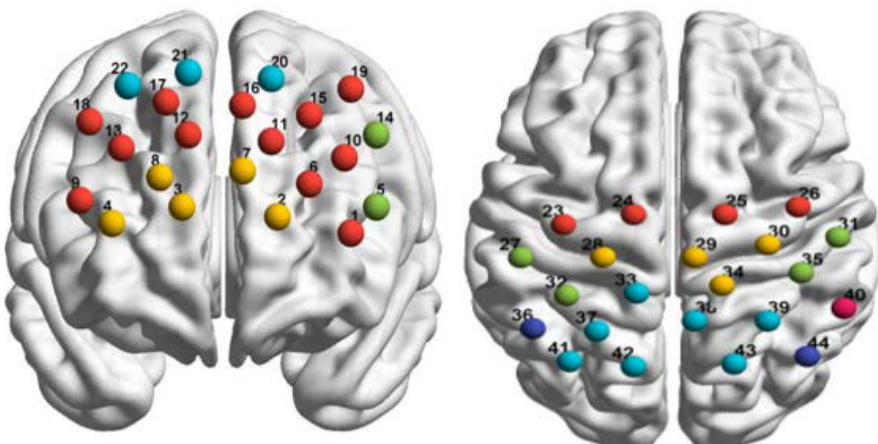
Figure 4. Schematic diagram of 44 channels over the frontal lobe and parietal lobe ( left : frontal lobe; right : parietal lobe).